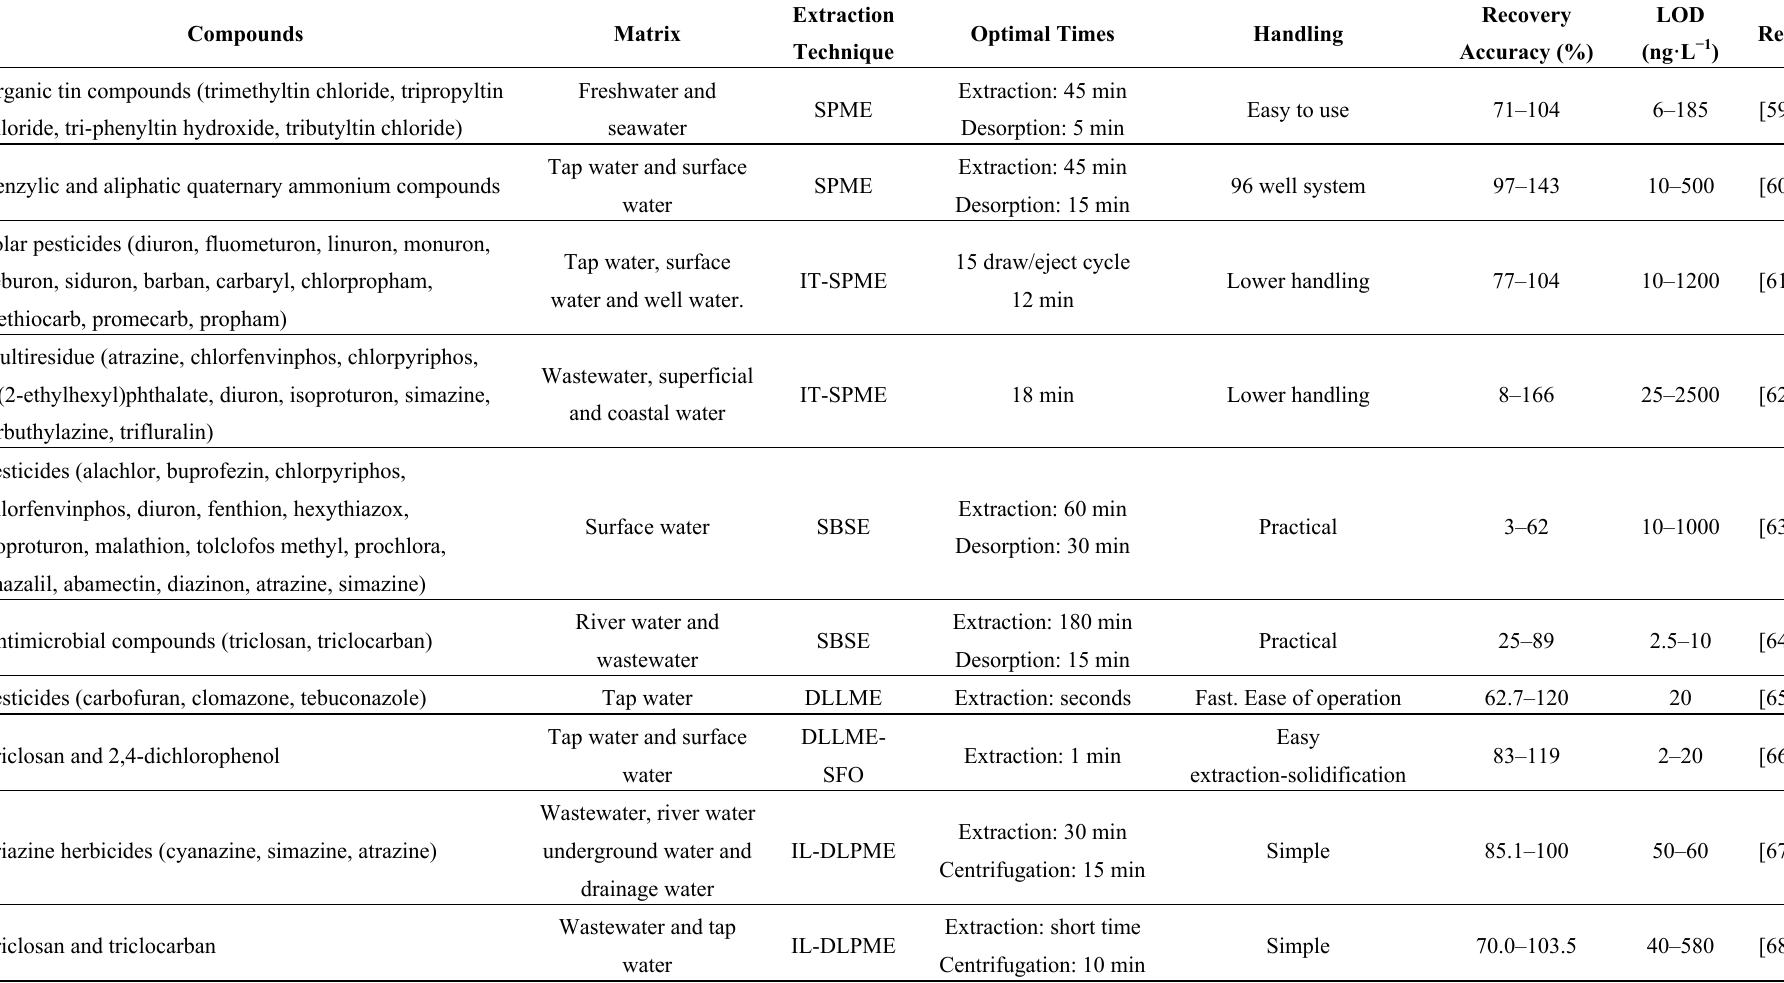
Table 1. Microextraction techniques to determine pesticides in environmental water samples by liquid chromatography-tandem mass